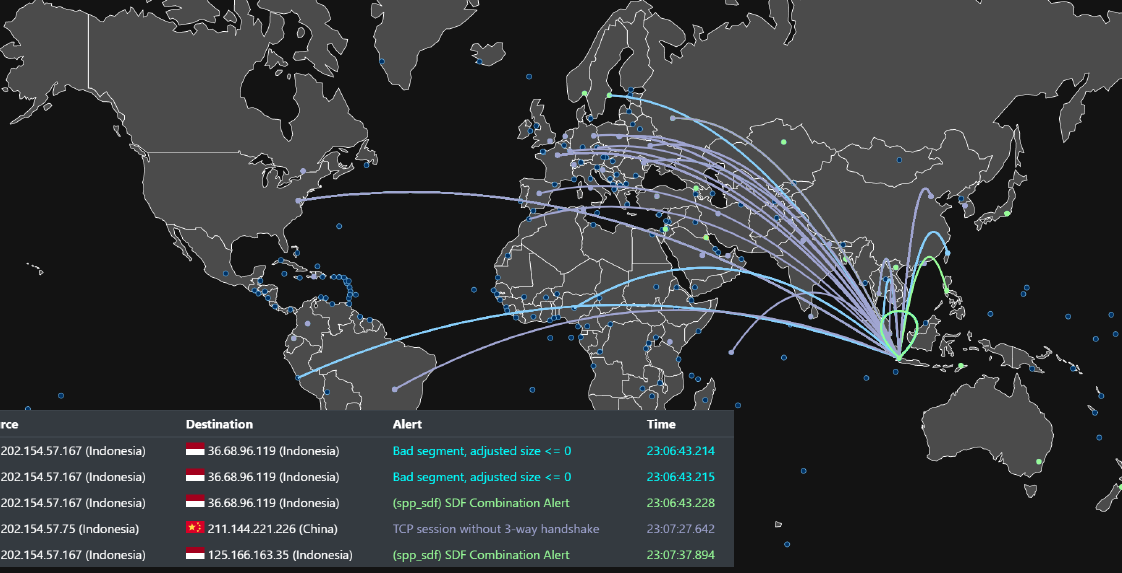
Figure 10. The client web page shows the attacks maps.